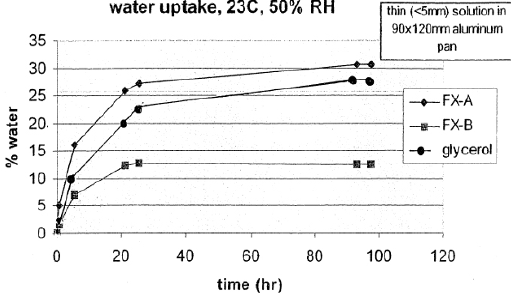
Figure 10. Off-gassing of sulphur dioxide from base treated HAF.